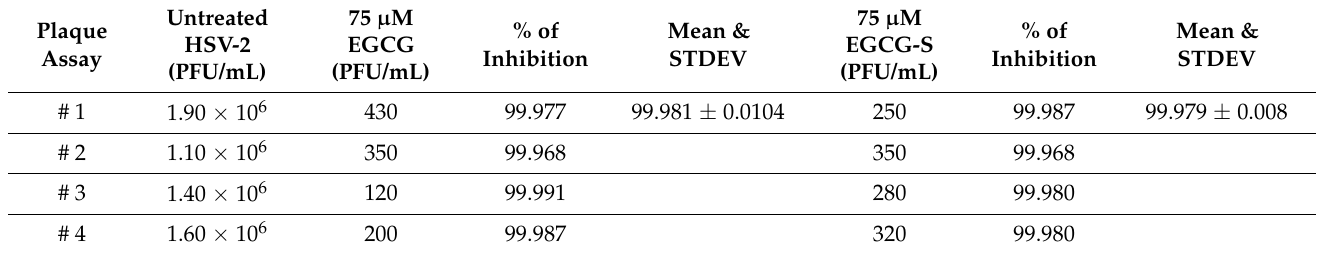
Table 1. Viral titers in response to 75 µ M EGCG and 75 µ M EGCG-S treatments of HSV-2